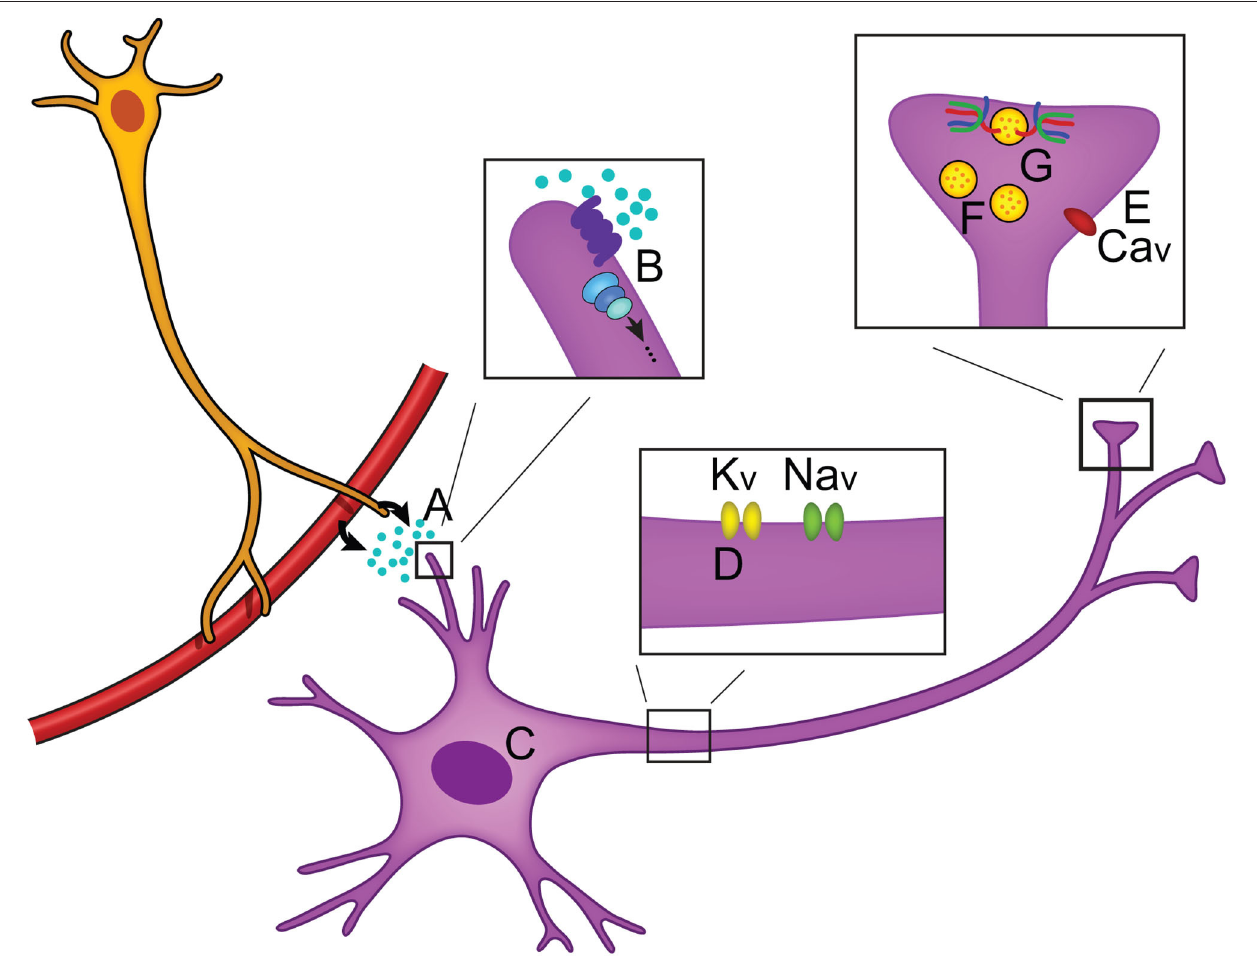
FIGURE 1 | Overview of neuromodulation. (A) Neuromodulators can be released locally or circulated from the periphery and often bind to GPCRs (B) to activate intracellular signaling cascades. Intracellular effects include changes in (C) gene expression, (D) axonal sodium and potassium ion channel activity, and (E) changes in calcium ion channel activity ( Zhou et al., 2007; Gray et al., 2017; Williams et al., 2018). (F) Neuronal activity can be modulated by changing the number of vesicles that are in the reserve pool, readily releasable pool, or docked at the synaptic terminal, thus changing the likelihood of neurotransmitter release (Rosenmund and